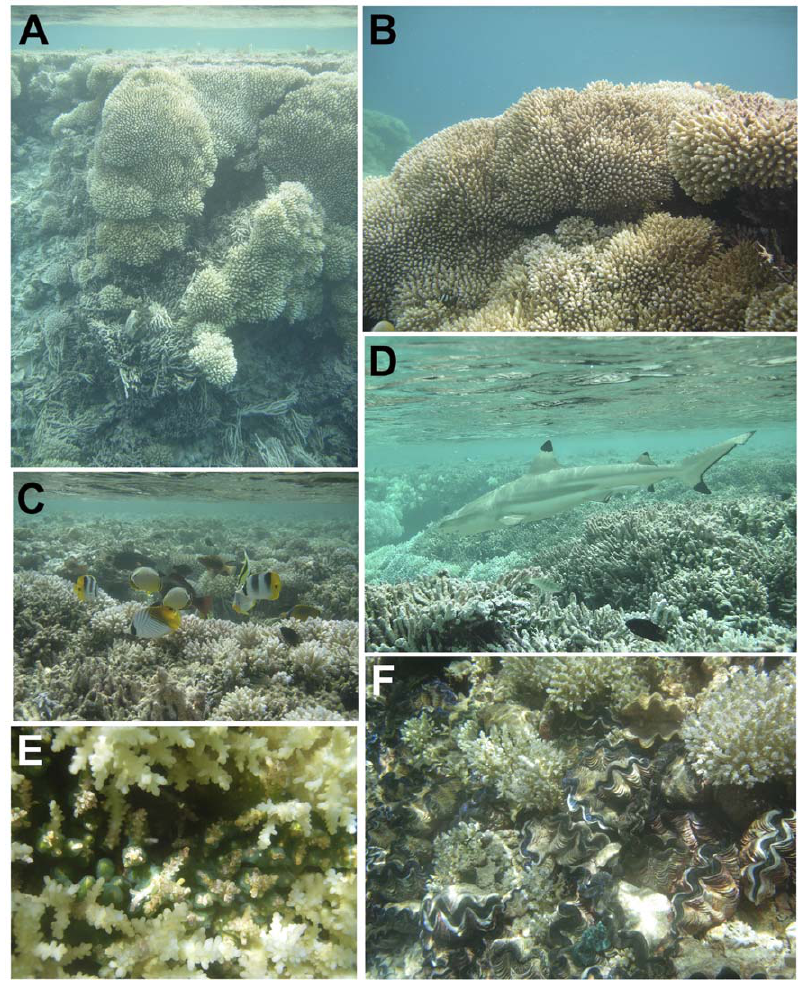
Figure 3. Representative images of common lagoon organisms. A) Patch reef dominated by Acropora spp. Tumbling of colonies down the slope along the edge of the reef is evident. B) Example of Acropora spp. dominant throughout the lagoon. C) Fish assemblage along the top of a patch reef. D) Blacktip reef shark. E) Ascidians (green) growing in the crevices of Acropora spp. colonies. F) Tridacna maxima growing among Acropora spp.